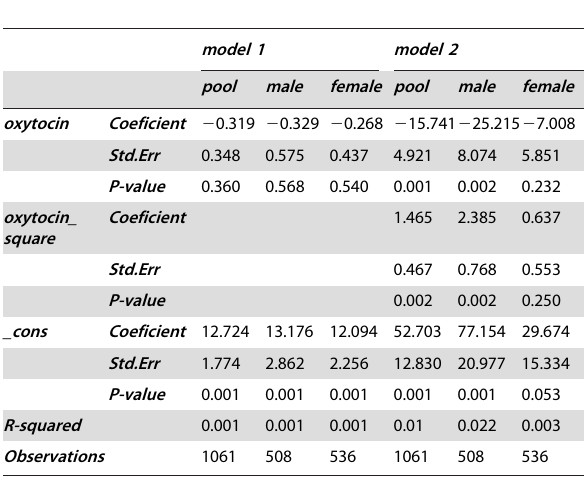
doi:10.1371/journal.pone.0051095.t001